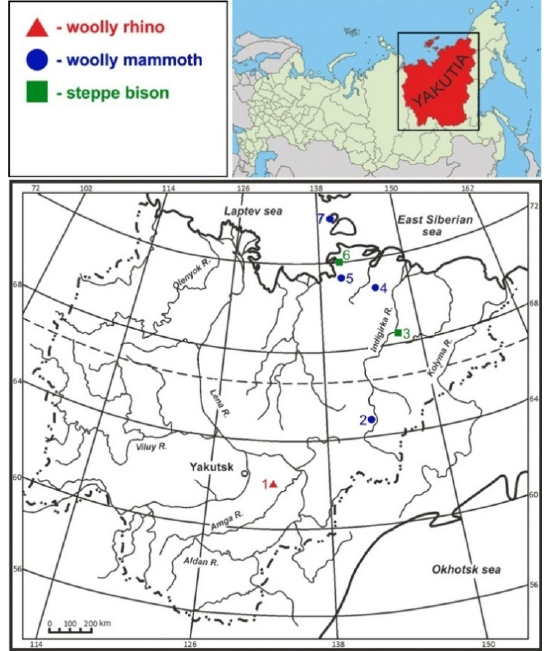
Figure 1. Study area map with location of fossil mammals discovered. Study sites were numbered from south to